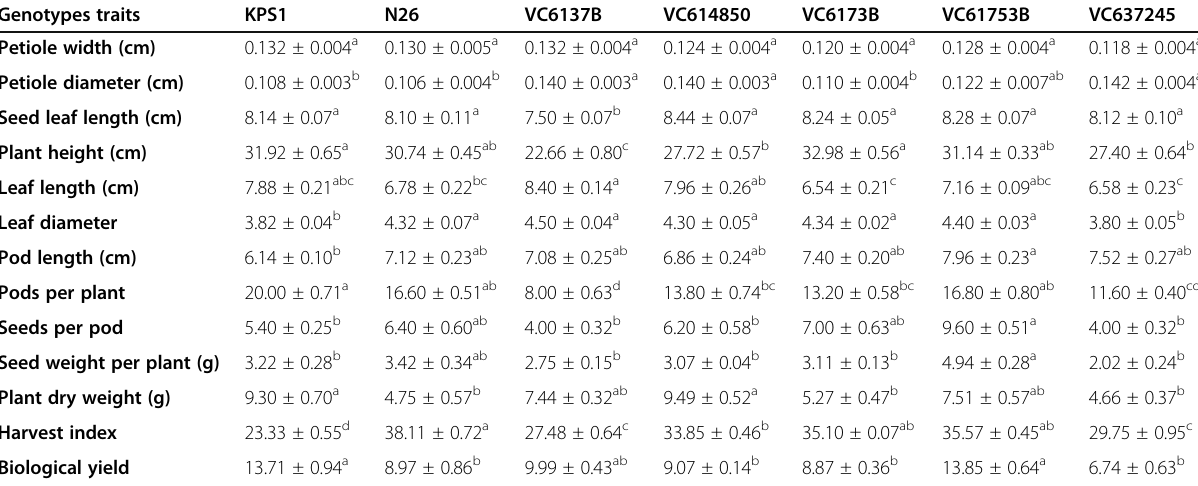
Table 2 Morpho-agronomic traits for the 7 Vigna radiata genotypes Genotypes traits